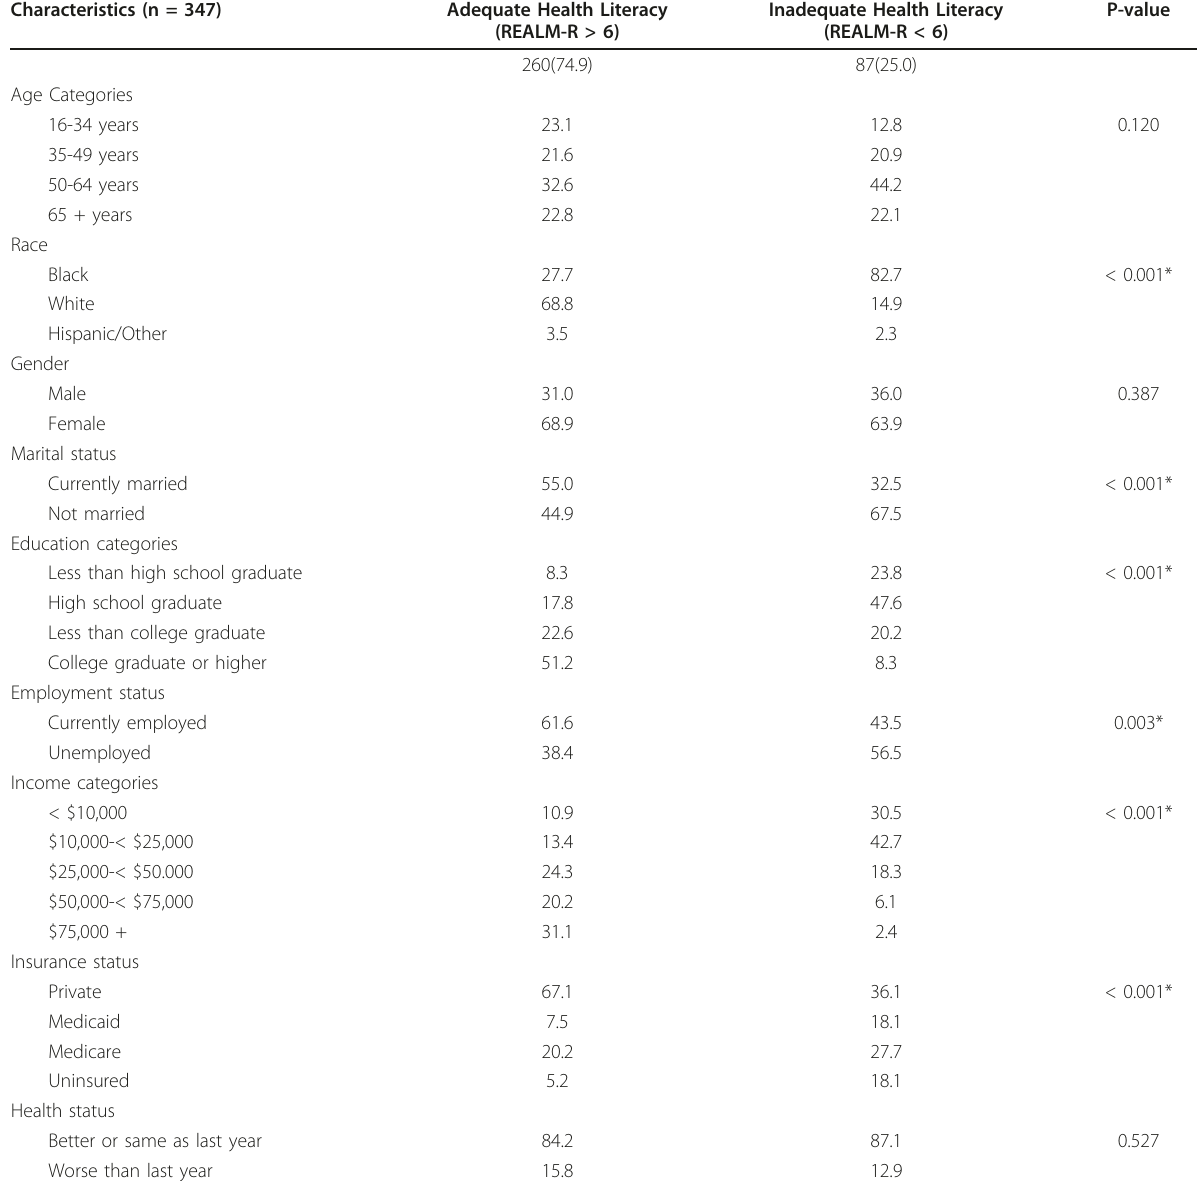
Table 1 Sample Characteristics by Health Literacy Levels Characteristics (n = 347) Adequate Health Literacy